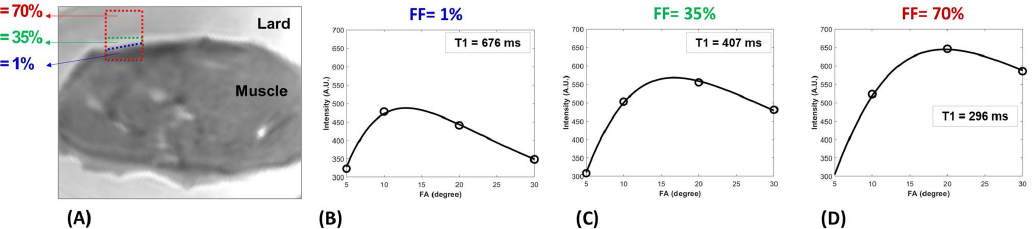
Figure 2. ( A ) T1-weighted UTE MRI image of the bovine muscle specimen embedded in lard. The blue box (dotted line) indicates an exemplary ROI with FF ≈ 1 % that expanded by only adding the neighboring lard voxels up to FF = 35% (green box, dotted line) and then FF = 70% (red box, dotted line). UTE-T1 recovery fitting curves for the ROI with ( B ) FF = 1% (T1 = 676 ms), ( C ) FF = 35% (T1 = 407 ms), and ( D ) FF = 70% (T1 = 296 ms).